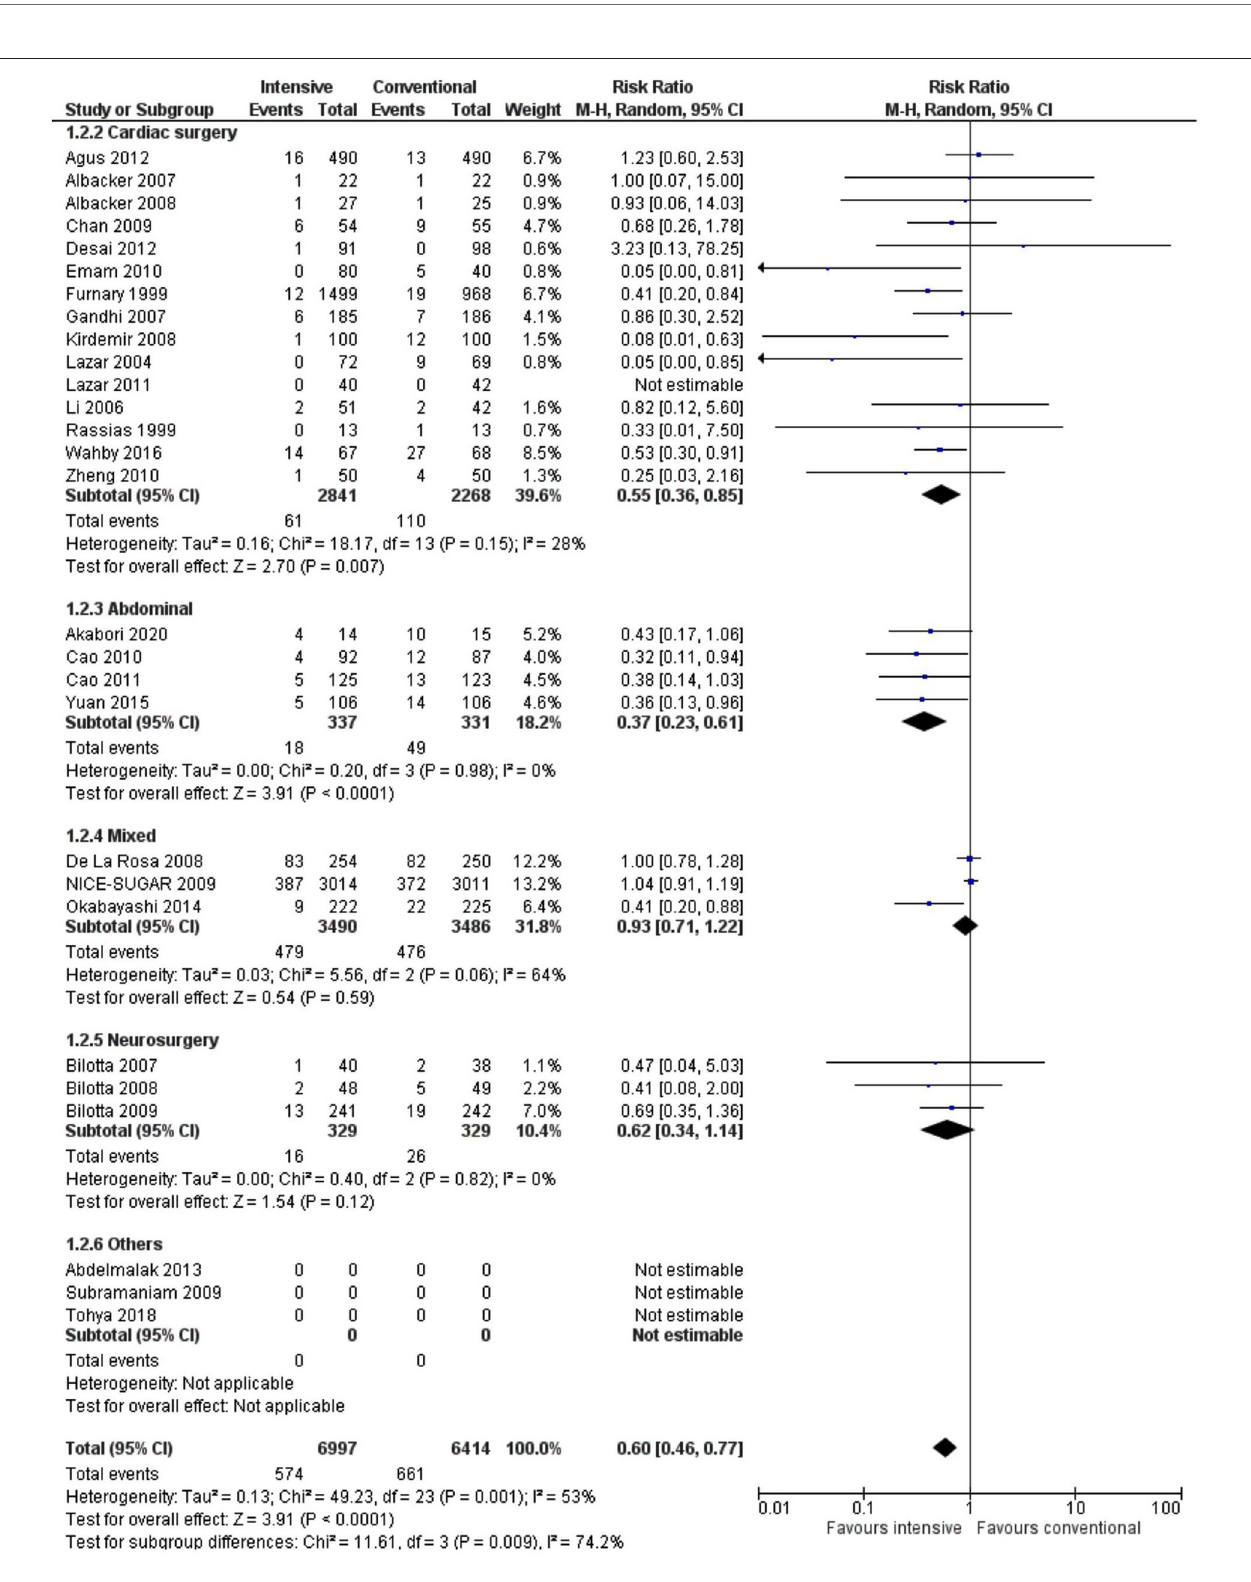
FIGURE 6 | A forest plot for a subgroup analysis according to surgery type in studies using a random-effects model. RRs and 95% CIs are shown.